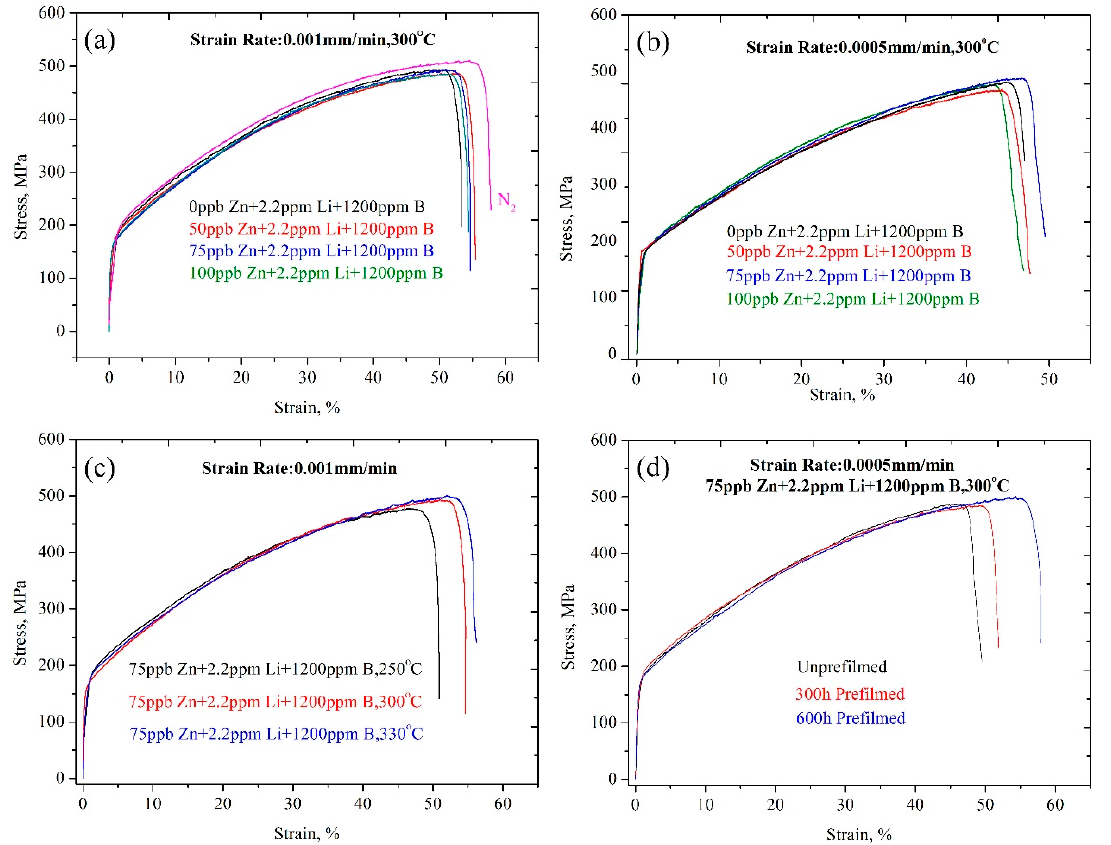
Figure 2. Stress–strain curves of the 316LN stainless steel tested at the conditions of ( a ) 0.001 mm/min tensile rate; ( b ) 0.0005 mm/min tensile rate; ( c ) different temperature; and ( d ) different prefilm time. Table 3. Tensile properties of 316LN SS after the SSRT test.